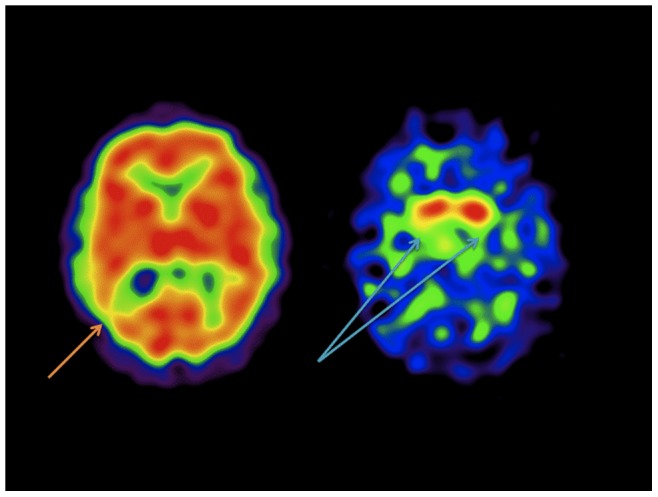

99mTc Exametazime and 123I Ioflupane SPECT studies in a 58 year old male subject with a history of a single TBI with clinically presenting with problems with memory, sleep, and vertigo and no clear parkinsonian features.The CBF shows only a mild decrease in the right temporo-parietal region. However, DAT binding is markedly abnormal with preserved uptake primarily in the caudate (R>L) and minimal uptake in the putamen bilaterally.